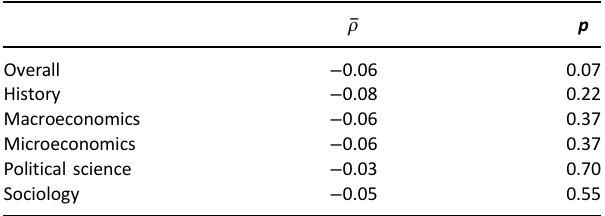
Table 4. Average correlation between final exam scores